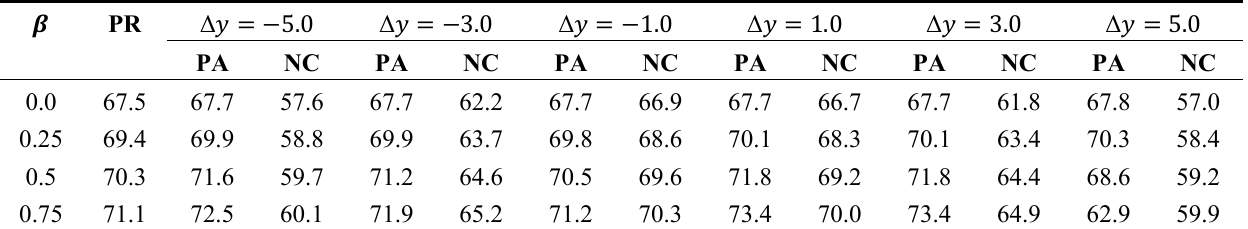
Table 12. Overall accuracies for different values of β in two extreme cases and our proposed algorithm for different initial displacement error in the y-direction Δy where PA and NC denote the cases of the proposed algorithm and no registration error correction, respectively.